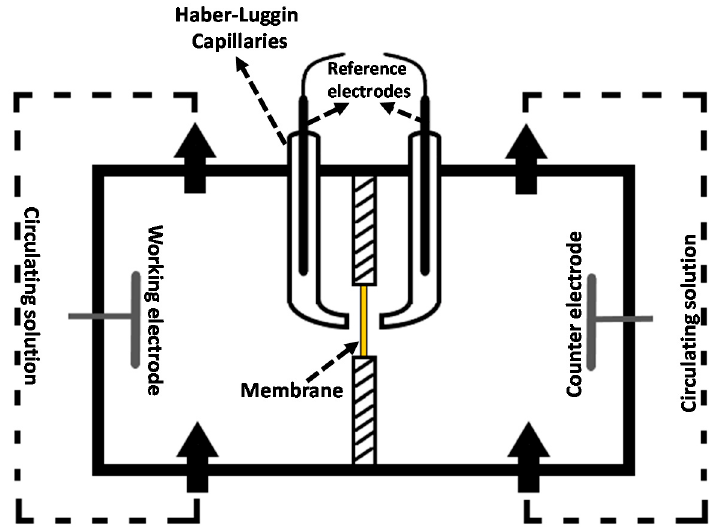
Figure 5. Scheme of the two compartments / four electrodes electrochemical impedance